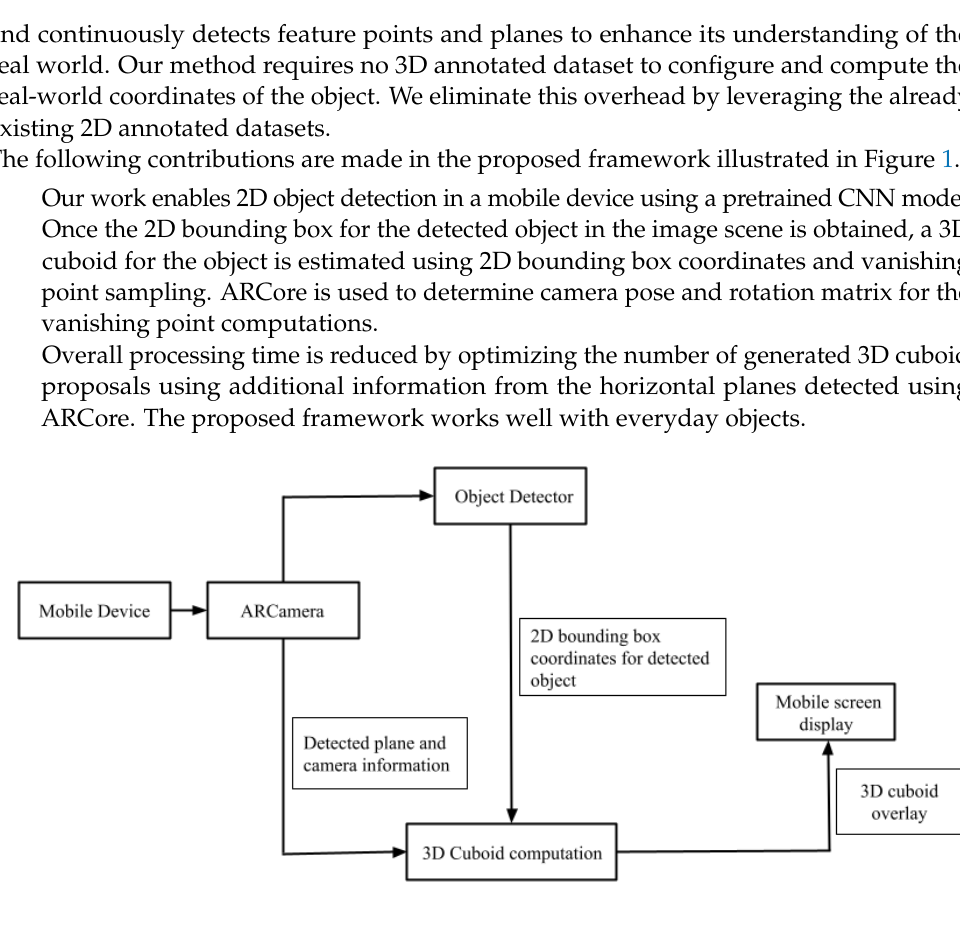
Figure 1. Flowgraph of the proposed